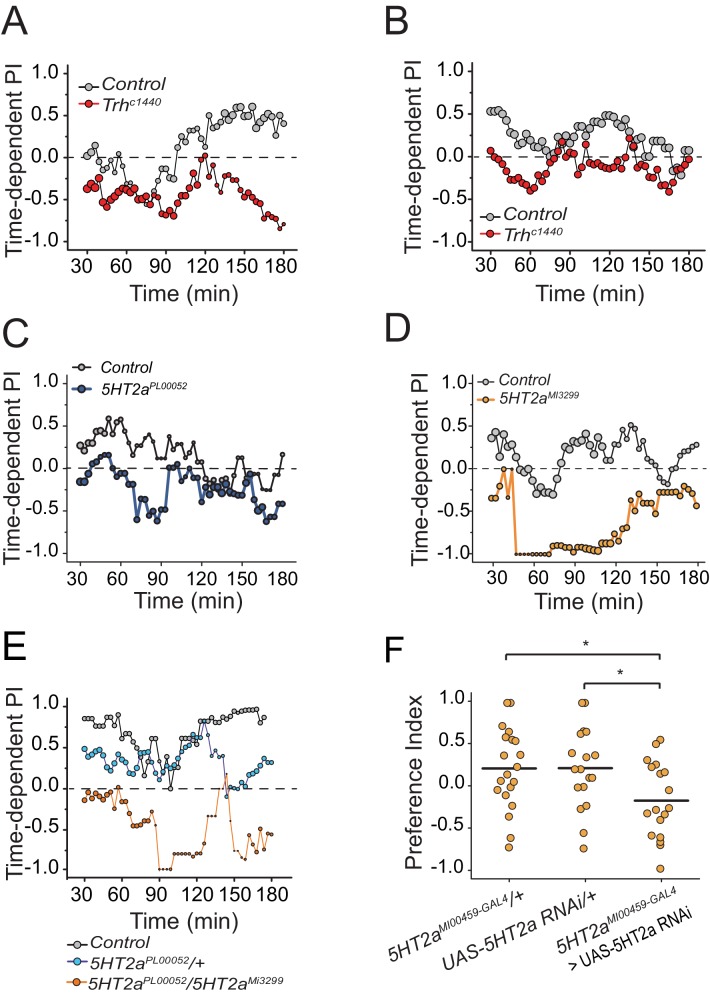
The effect of serotonin manipulations on protein choice behavior is robust and reproducible.(A-B) Replicate experiments that serve as companions to Figure 2B. Time-dependent PI plot of control and Trh mutant flies on 1% sucrose vs. 1% sucrose + 2% autolyzed yeast. (C) A replicate experiment that serves as a companion to Figure 2D. Time-dependent PI plot of control and 5HT2aPL00052 mutant flies on 1% sucrose vs 1% sucrose + BSA. (D) Time-dependent preference plot of flies carrying another mutant allele of 5HT2a (5HT2aMI3299). The preference was abrogated as seen in the other 5HT2a mutant. The choice was given as 1% sucrose vs. 1% sucrose + BSA. (E) Time-dependent PI plot showing protein preference of starved flies heterozygous for 5HT2aPL00052 and trans-heterozygous for 5HT2aPL00052/ 5HT2aMI3299. The choice was given as 1% sucrose vs 1% sucrose + 2% autolyzed yeast. The protein preference is abrogated in the trans-heterozygote mutants. (F) We genetically knocked-down 5HT2a transcript level in the 5HT2a-positive neurons using 5HT2aMi00459-GAL4> UAS-5HT2a RNAi and tested protein preference of female flies. The choice was given as 2% autolyzed yeast +1% sucrose vs. 1% sucrose. Genotype effect was tested with one-way ANOVA followed by Tukey's multiple comparison (*P≤0.05).